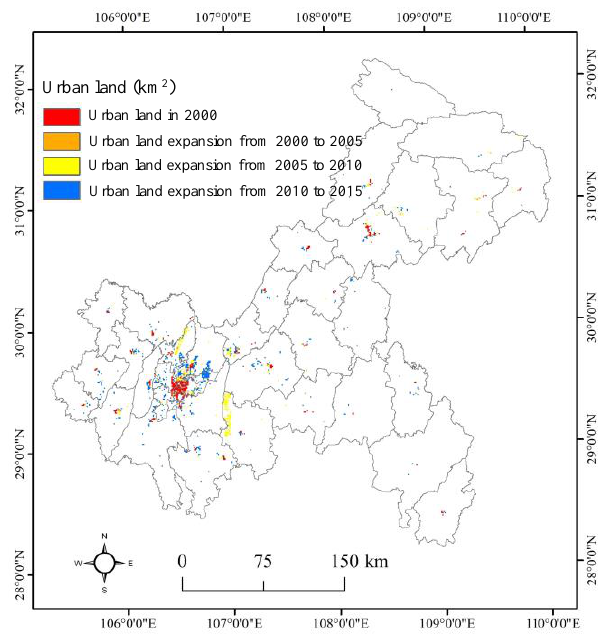
Figure 2. Urban land expansion in Chongqing from 2000 to 2015.